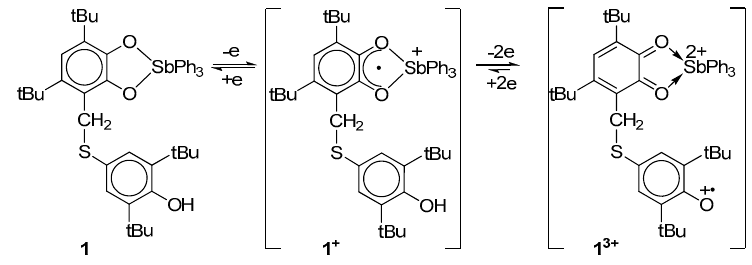
Scheme 5. The electrochemical oxidation of complex 1 .